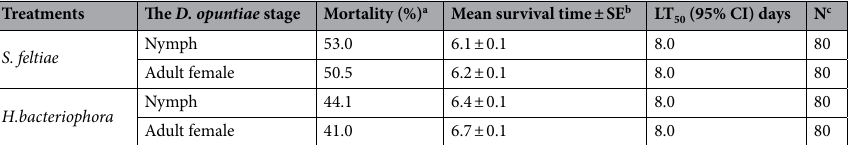
Table 3. Mortality (%), mean survival time, and LT 50 (days) of Dactylopius opuntiae -treated nematode strains with concentration 50 IJs cm −2 . a Abbott-corrected percentage mortality of D.opuntiae nymphs and adults female at the end of experiment. b The mean survival time and its standard error. c Total number of D. opuntiae in bioassay.